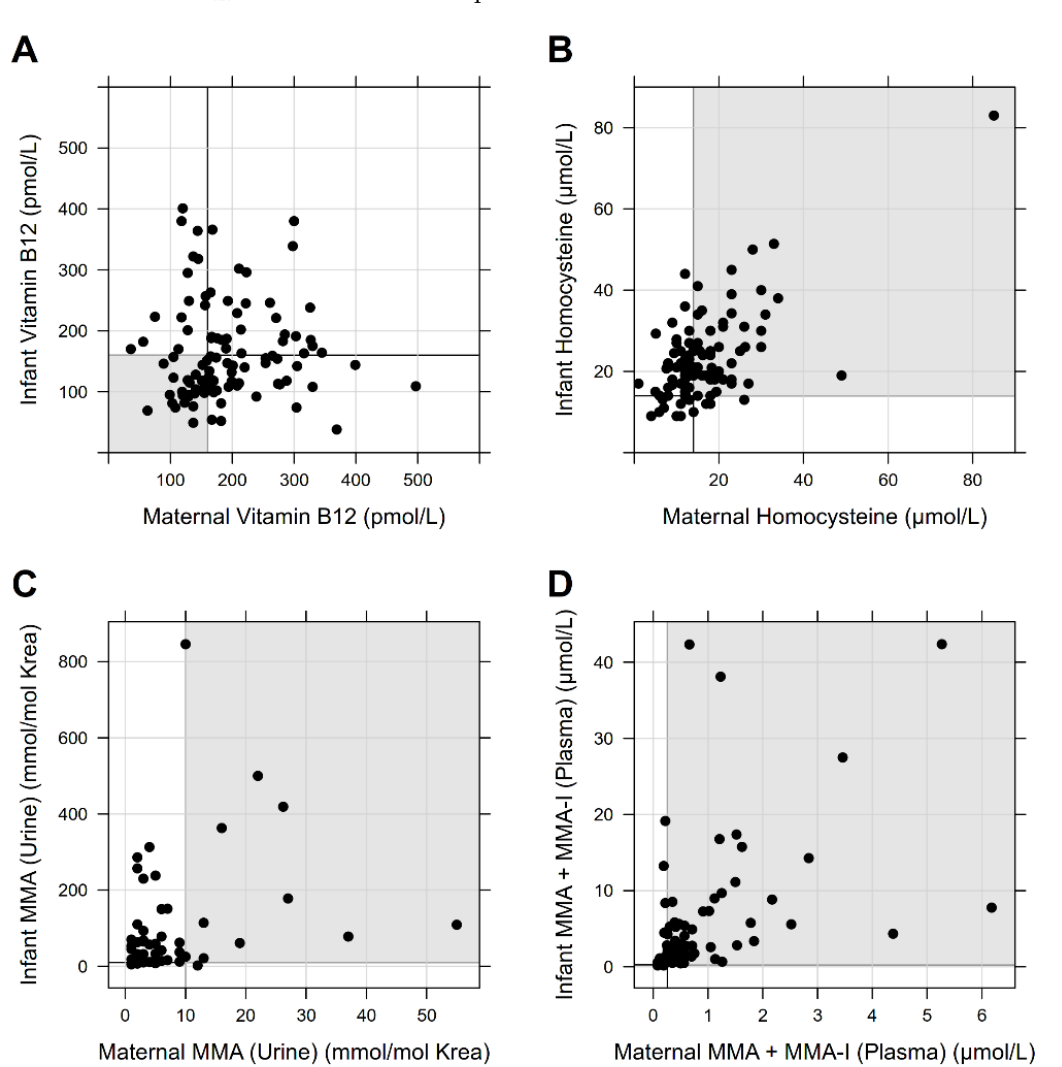
Figure 1. Relation of maternal and infant vitamin B 12 status. ( A – D ) illustrates the correlation of the maternal and infant vitamin B 12 status based on the vitamin B 12 levels and the functional parameters Hcy, MMA in urine, and MMA or MMA-I in plasma as a point cloud. Bold lines mark the cut-off of the normal range. Individuals in the gray marked area showed values outside the normal range for both mother and